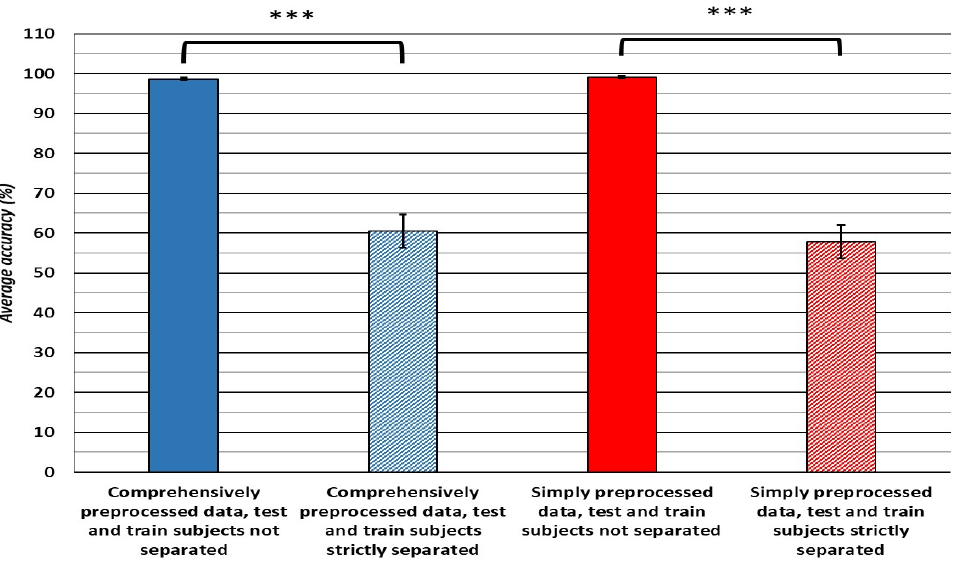
Figure 4. The comparison of hold-out validation accuracies on randomly sampled hold-out data and hold-out data belonging to the same subjects. The *** symbol denotes statistical significance at the level of p < 0.001. The error bars depict 95% confidence intervals for the mean.